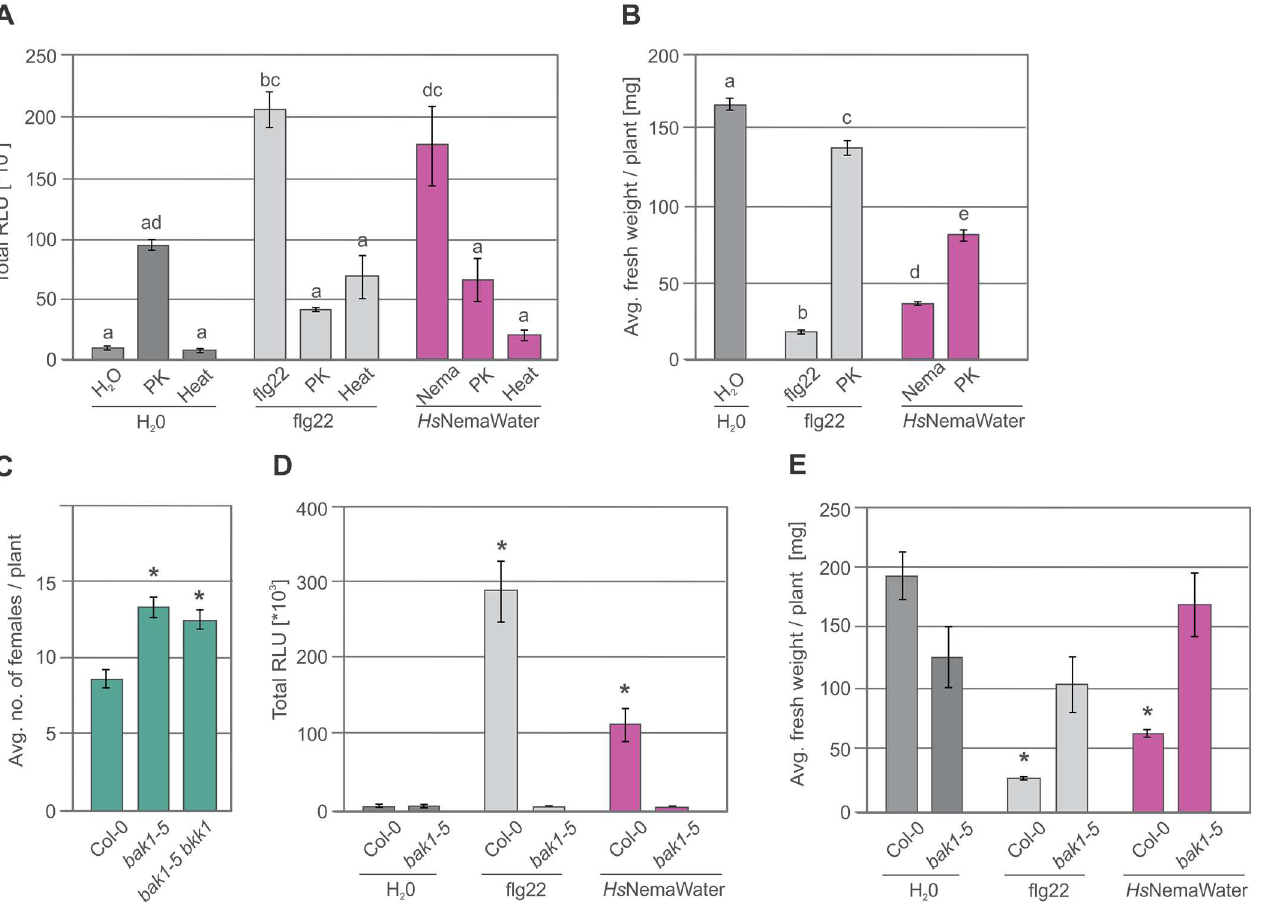
Fig 4. NemaWater treatment induced PTI responses were reduced strongly upon proteinase K, heat treatment, and in bak1-5 plants. ( A ) Effect of Proteinase K and heat on productionof ROS burst in root segmentsfrom Col-0 plants treated with water, Hs NemaWater or flg22. ROS burst was measuredby using L-012 basedassay from 0 to 120 min. PK, Proteinase K. Bars represent mean ± SE for two independentbiological replicates. Data were analysedusing single-factor ANOVA and Tukey’s post hoc test (P < 0.05). Columnssharing same letter are not statistically different. ( B ) 5-day-oldCol-0 seedlingswere incubatedin water, Hs NemaWater, or flg22 with or without Proteinase K for seven days. Fresh weight was measuredat 12 days after germination. Bars represent mean ± SE for two independentbiological replicates. Data were analysedusing single- factor ANOVA and Tukey’s post hoc test (P < 0.05). Columns sharing same letter are not statistically different. ( C ) Average numberof female nematodes per plant in Col-0, bak1-5 and bak1-5 bkk1 . ( D ) Root segments from Col-0 and bak1-5 plants were treated with water, Hs NemaWater or flg22 and ROS burst was measuredusing L-012 basedassay from 0 to 120 min. ( E ) 5-days-oldCol-0 and bak1-5 seedlings were incubatedin water, Hs NemaWater or flg22 for seven days. Fresh weight was measuredat 12 days after germination.( C-E ) Bars represent mean ± SE for three independent biologicalreplicates. Data were analyzedusing single-factor ANOVA and Dunnet post hoc test. Asterisks represent significant difference to control (P < 0.05).